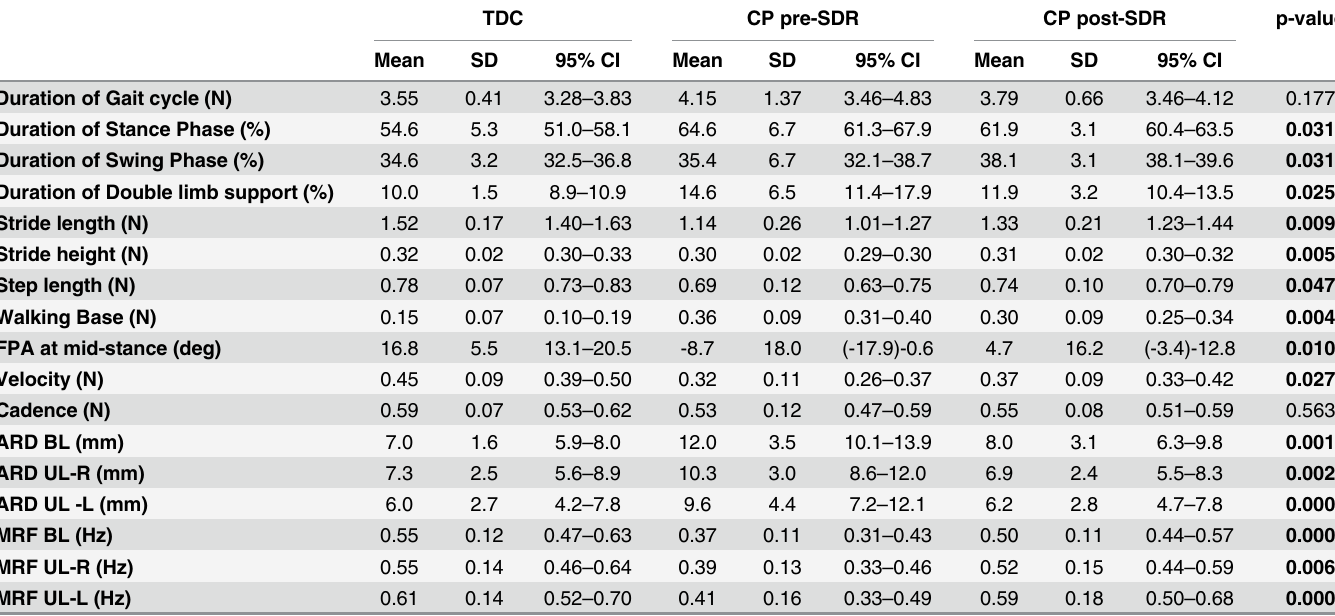
Table 2. Absolute spatiotemporal values and radial balance